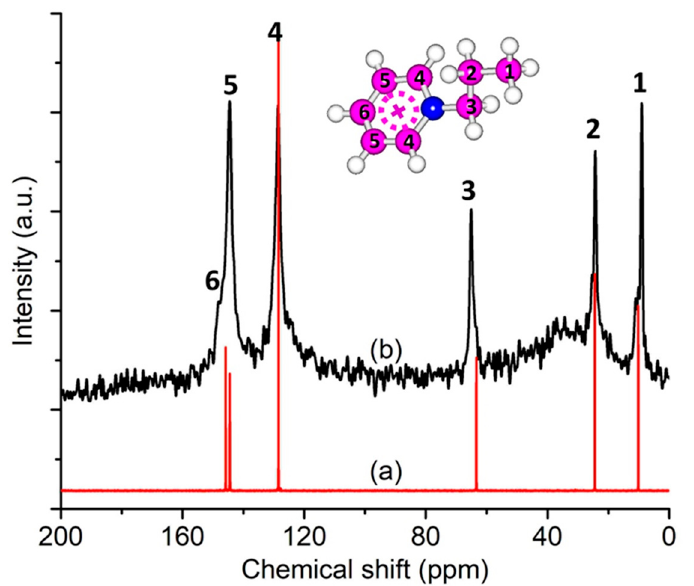
Figure 7. ( a ) Liquid state NMR spectrum of [PPy]Br ionic molten salt, and ( b ) solid state MAS NMR Figure 7. (a) Liquid state NMR spectrum of [PPy]Br ionic molten salt, and (b) solid state MAS NMR spectrum of as-synthesized SAPO-11 (E-3). spectrum of as-synthesized SAPO-11 (E-3).